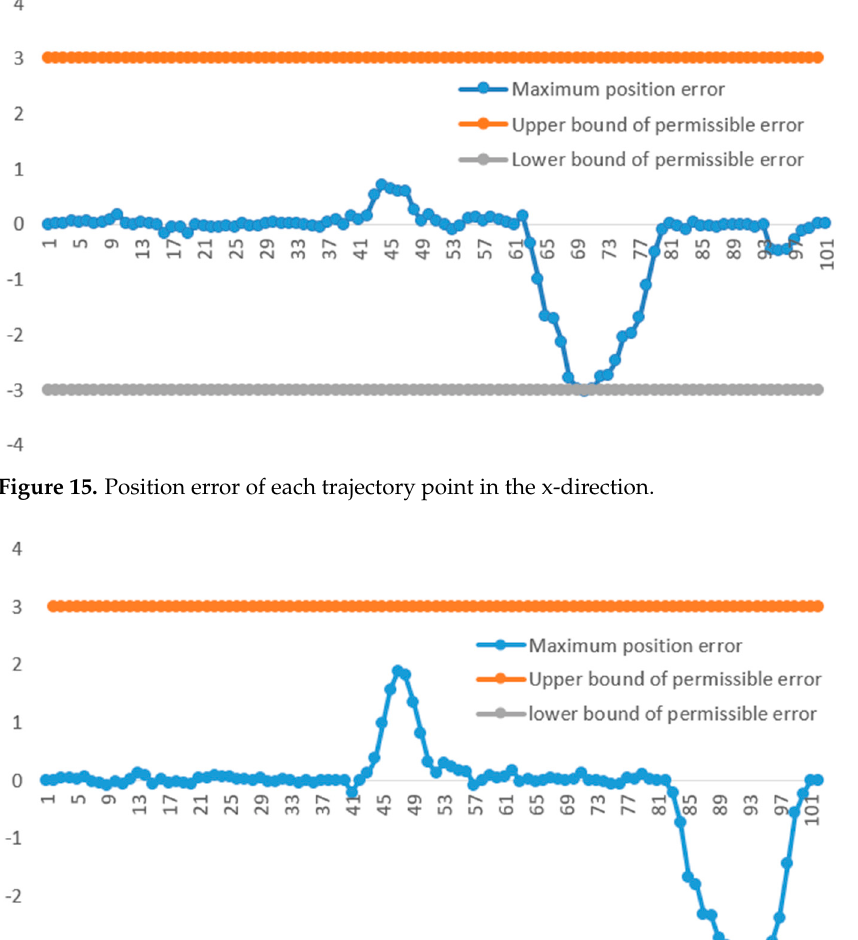
Figure 17. Position error of each trajectory point in the z ‐ direction.